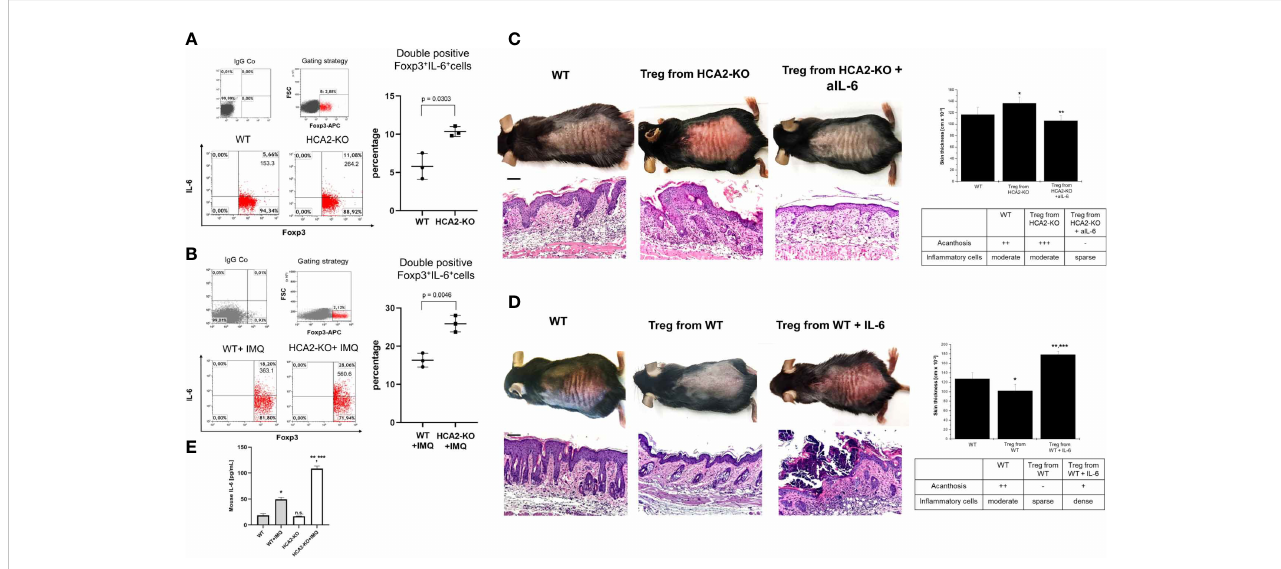
FIGURE 5 IL-6 appears to be involved in the alteration of Treg in the absence of HCA2. Pooled LN cells and splenocytes obtained from 4 naïve mice (A) or 4 IMQ- treated (B) WT and HCA2-KO mice were analyzed for double positive Foxp3/IL-6 cells and is demonstrated as percentage and total number of double positive cells. FACS analysis is also shown as a scatter graph with mean ± SD. Y axes show percentage of double positive cells. Data were analyzed by using the t test with Welch´s correction. n = 3 (C) Treg were obtained from naïve HCA2-KO or from HCA2-KO mice injected i.p. with a rat monoclonal anti-IL-6 antibody. The isolated Treg cells were injected i.v. into IMQ-treated WT mice. Biopsies from IMQ-treated recipients were taken; paraf fi n embedded sections were stained with H&E and analyzed histopathologically. Scale bar = 100µm. Skin thickness was measured using a spring-loaded micrometer. Student t test and one-way ANOVA was performed. *P < 0.025 WT vs Treg from HCA2-KO, **P < 0.0003 Treg from HCA2-KO vs Treg from HCA2-KO+anti IL-6; P ANOVA = 9.9x10 -4 . Acanthosis and density of in fl ammatory in fi ltrate were scored. Each group contained 7 animals. (D) Treg were obtained from naïve WT mice or WT mice injected i.p. with IL-6. The isolated Treg cells were injected i.v. into IMQ-treated WT mice. Biopsies from IMQ- treated recipients were taken; paraf fi n embedded sections were stained with H&E and analyzed histopathologically. Macroscopical and histopathologic pictures of untreated WT mice are not shown for the sake of space. Scale bar = 100 µm. Skin thickness was measured using a spring-loaded micrometer. Student t test and one-way ANOVA was performed. *P < 0.02 WT vs Treg from WT, **P < 0.0002 WT vs Treg from WT+IL-6, ***P < 0.002 Treg from WT vs Treg from WT+IL-6; P ANOVA = 3.2x10 -5 . Acanthosis and density of in fl ammatory in fi ltrate were scored. Each group contained 7 animals. Data are presented from one of three independent experiments. (E) Serum was obtained from untreated or IMQ-treated WT and HCA2-KO mice, respectively, and IL-6 serum levels were measured using an ELISA. Data were analyzed by using the t test with Welch´s correction and one-way ANOVA. *P = 0.0004 WT vs WT+IMQ; **P = 0.0008 HCA2-KO vs HCA2-KO+IMQ; ***P = 0.0001 WT+IMQ vs HCA2-KO+IMQ; n.s. = 0.4098 WT vs HCA2-KO; P ANOVA = 3.05815x10 -11 ; n =